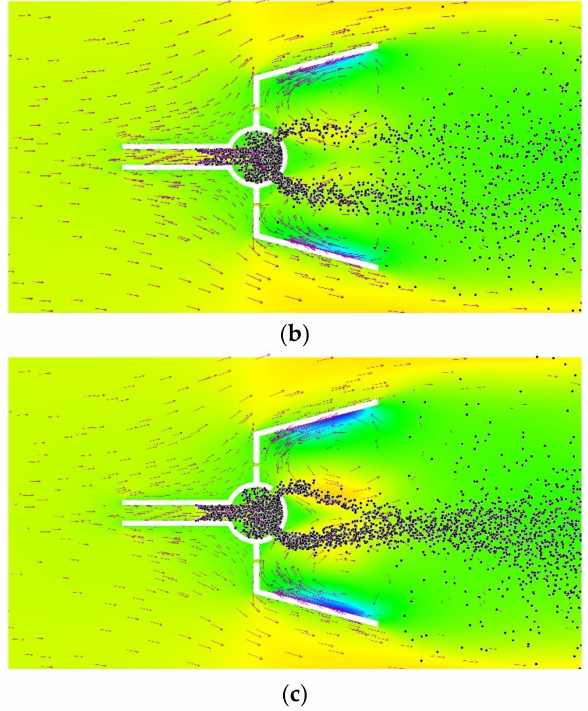
Figure 13. Spray field under different actuation intensities with 10 mm actuation length on inner